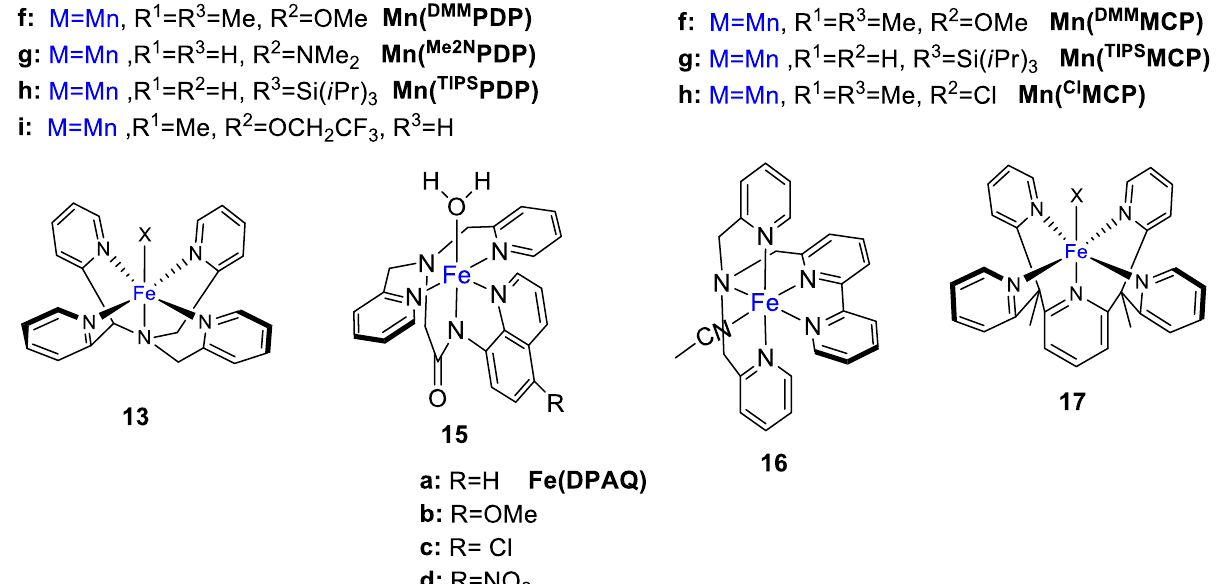
Figure 3. Structures of selected nonheme complexes.